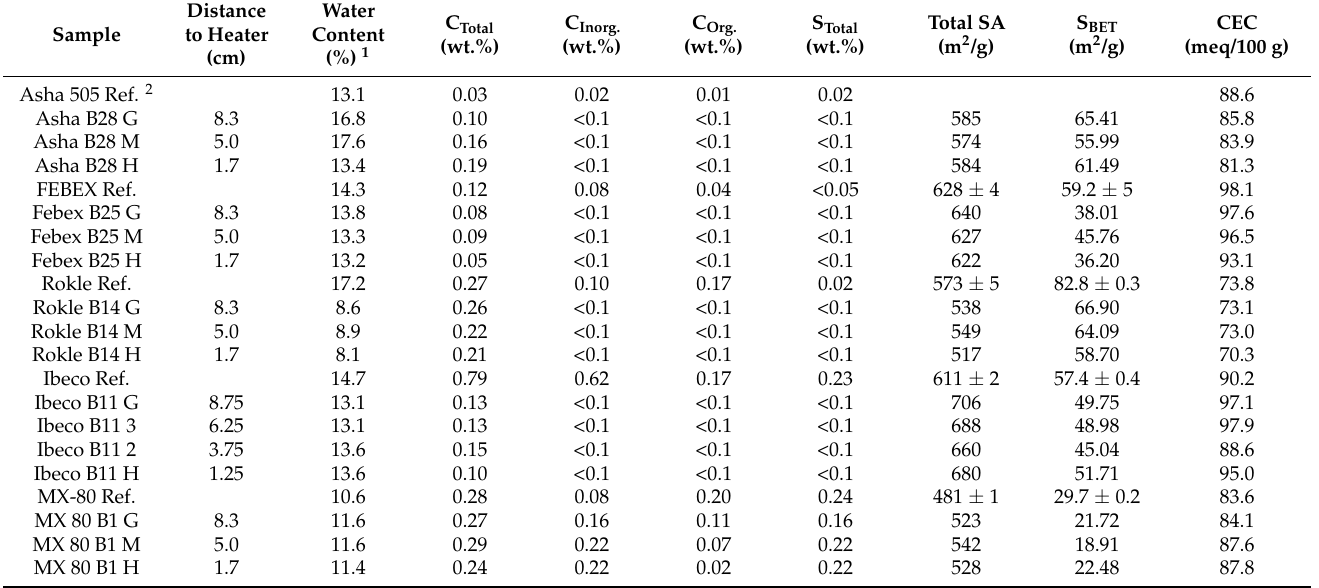
Figure 13. Iron content in the solid samples prior to and after the dismantling of the ABM5 experiment: Fe(II), Fe(III) and total Fe. Regarding carbon and sulfur contents (Table 9), no significant differences are observed, except for the presence of organic matter in the MX-80 bentonite block 1, but the values are lower than in the reference value. Table 9. Total carbon, total sulfur, total surface area (SA) and BET surface area obtained after the dismantling of